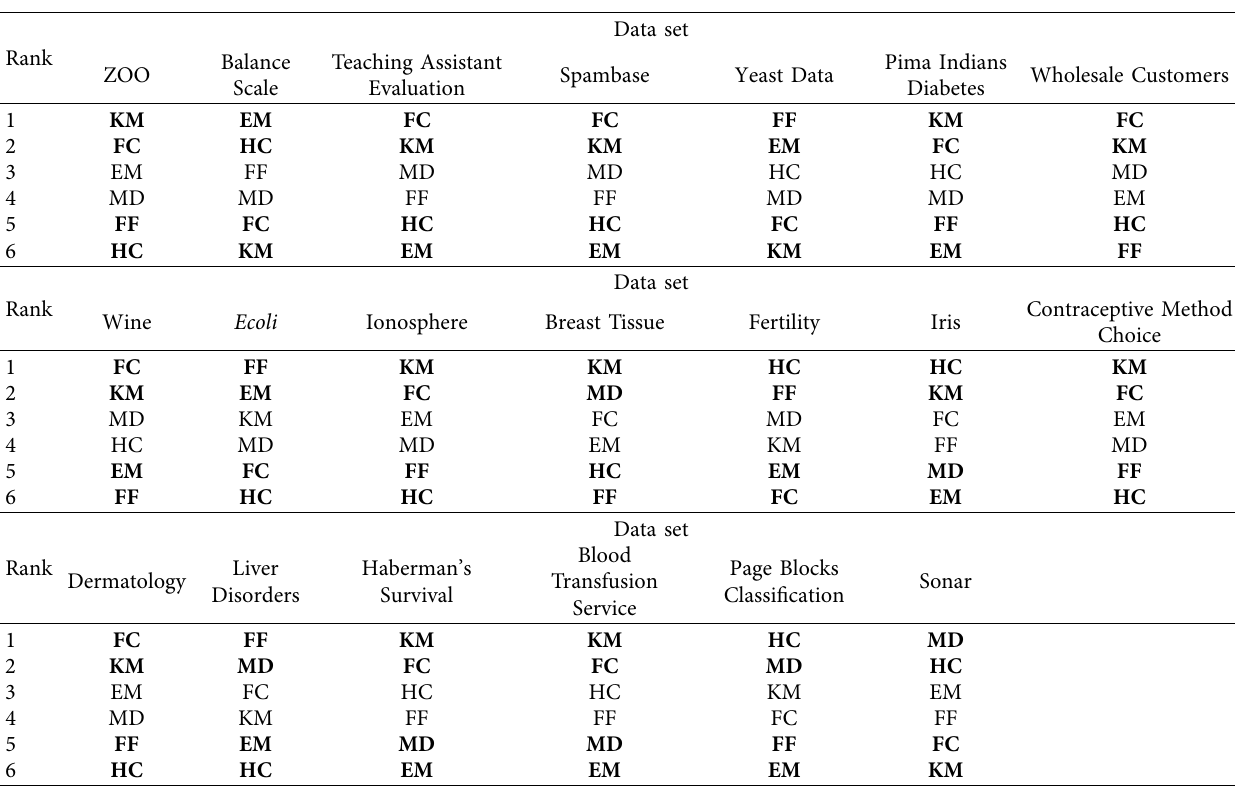
Table 9: Rankings of four MCDM methods for a total of 20 UCI data sets.